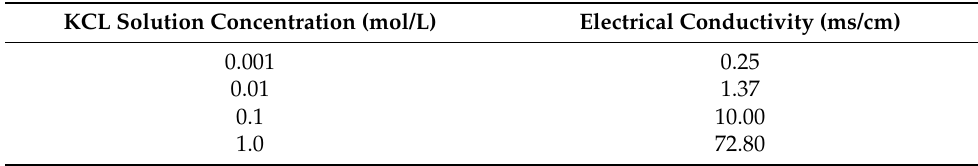
Table 1. Electrical conductivity of the KCL solution at different concentrations (20 ◦